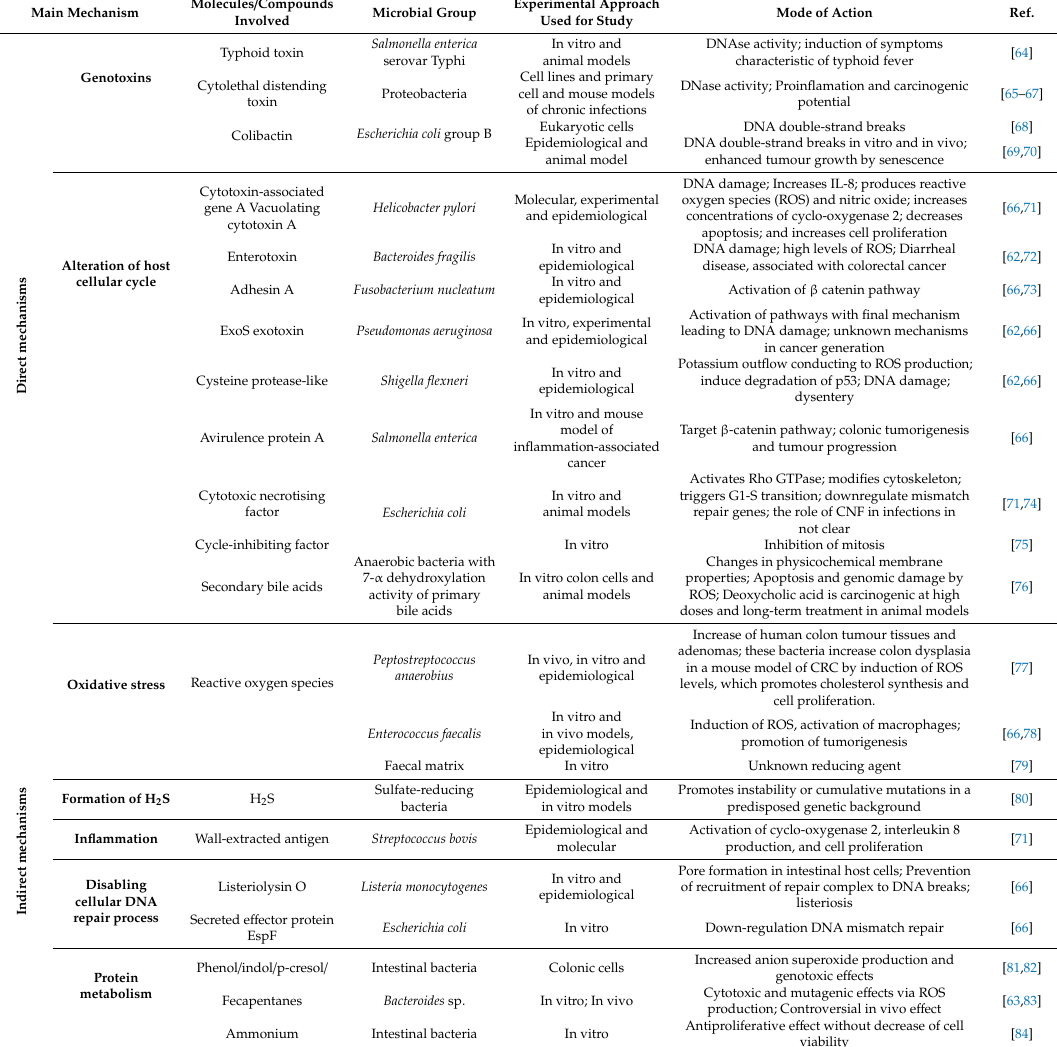
Table 2. Cytotoxic / genotoxic mechanisms of endogenous molecules and compounds generated by intestinal bacteria that could be involved in CRC. Direct mechanisms refer to those that promote genotoxic and / or cytotoxic action directly. Indirect mechanisms are those that cause damage at di ff erent levels, from which a cytotoxic and / or genotoxic action is